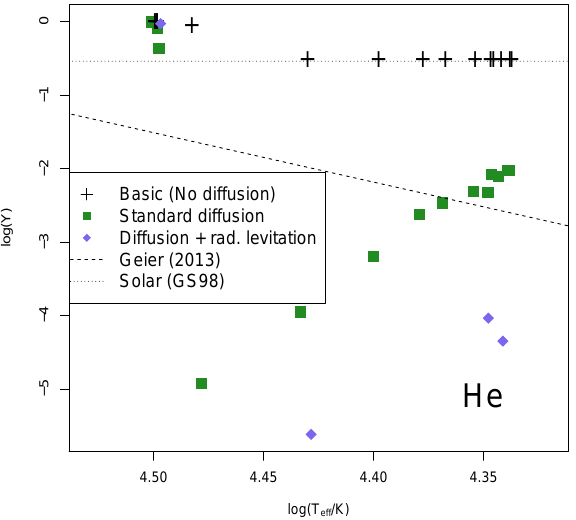
Figure 1. Surface helium mass fraction as a function of effective temperature for zero-age horizontal branch models. The black squares indicate models where no diffusion was included. The green squares show models where standard diffusion was included, while the blue diamonds represent models where diffusion and radiative levitation were included. The dotted and dashed lines rep- resent the solar surface values and average sdB values from Geier (2013)